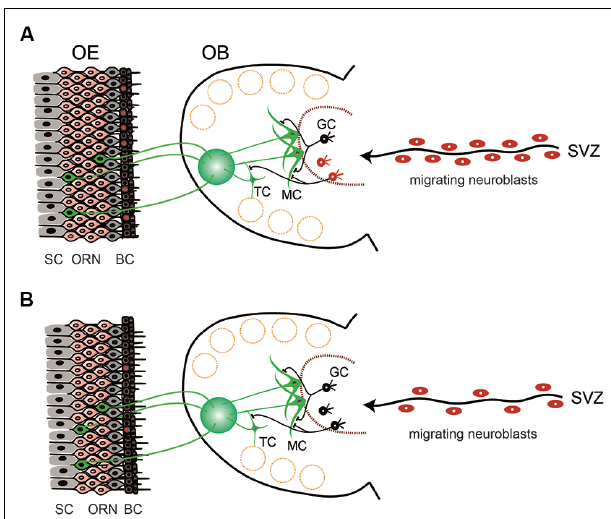
FIGURE 1 | Schematic view of the structure and cell dynamics of the olfactory neuroepithelium (OE) and olfactory bulb (OB) in young (A) and aged (B) mice. (A) OE is composed of layers of supporting cells (SC), olfactory receptor neurons (ORN), and basal cells (BC). BCs continuously undergo cell division to give rise to new neuronal cells (BCs with red nuclei). ORNs extend axons to the glomerulus of the OB, where they make synaptic connections with the neurites of mitral cells (MC) and tufted cells (TC). There is also continuous cell generation in the stem cell population in the subventricular zone (SVZ). Generated neuroblasts then migrate to reach the OB and differentiate into the interneurons [mostly into granule cells (GC)] and contribute to the modulation of olfactory information. (B) In aged animals, the cell division in the BCs is decreased and the number of ORNs is also reduced. Cell division in the SVZ is reduced, as well as the number of neuroblasts migrating to the OB. However, the number of granule cells in the OB is almost stable, suggesting that the turnover of granule cells is reduced and the lifespan of the cells is prolonged (black GCs).